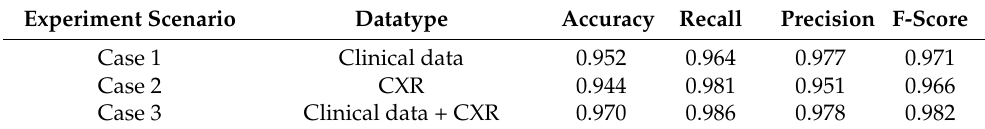
Table 4. Performance comparison of the proposed DL models for three different cases.